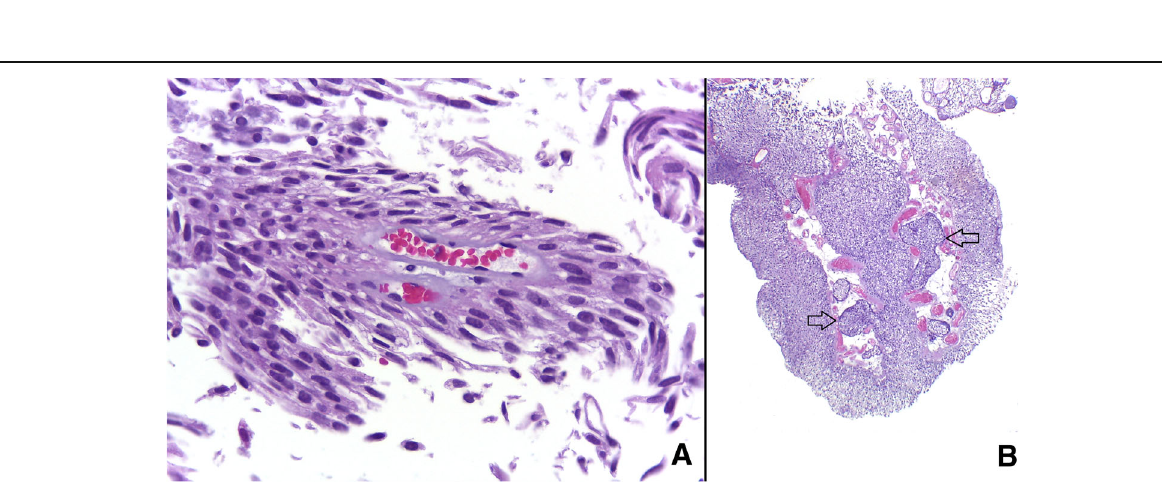
Fig. 4 High grade papillary urothelial lesion (H&E). There is loss of cell adhesion, with shedding of superficial cells (A; 40x). It is a high grade lesion, with hiperchromatic nuclei that have lost polarity. (B; 10x) The epithelial layer is densely cellular and thick and the fibrovascular core shows proliferated ectatic vessels, with foci of invasion through the basement membrane (arrow)